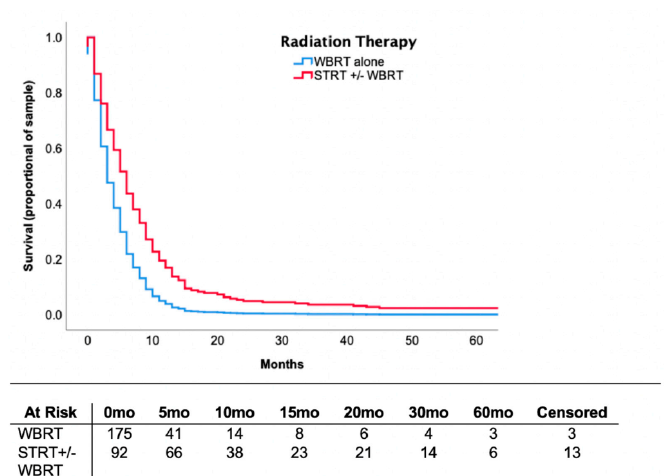
Figure 1. Proportional Cox regression survival curve demonstrating survival over months in patients receiving STRT ± WBRT versus WBRT alone. Hazard ratio (HR) = 0.401, 95% confidence interval (CI) = 0.294–0.548, p < 0.001 were associated with STRT ± WBRT compared to WBRT alone. Analysis controlled for age, LDH value, number of intracranial lesions, extent of extracranial disease, the presence of neurological symptoms, infratentorial lesions, surgery and systemic therapy. WBRT—whole brain radiation therapy; STRT—stereotactic radiation